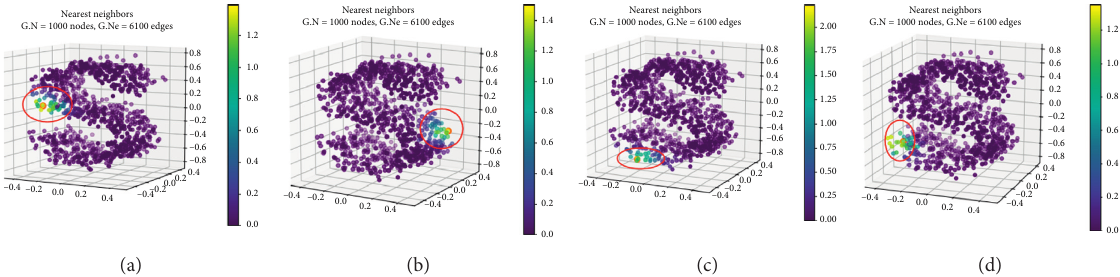
Figure 11: The graph spectral wavelet method used to determine the local range of anchor vector.